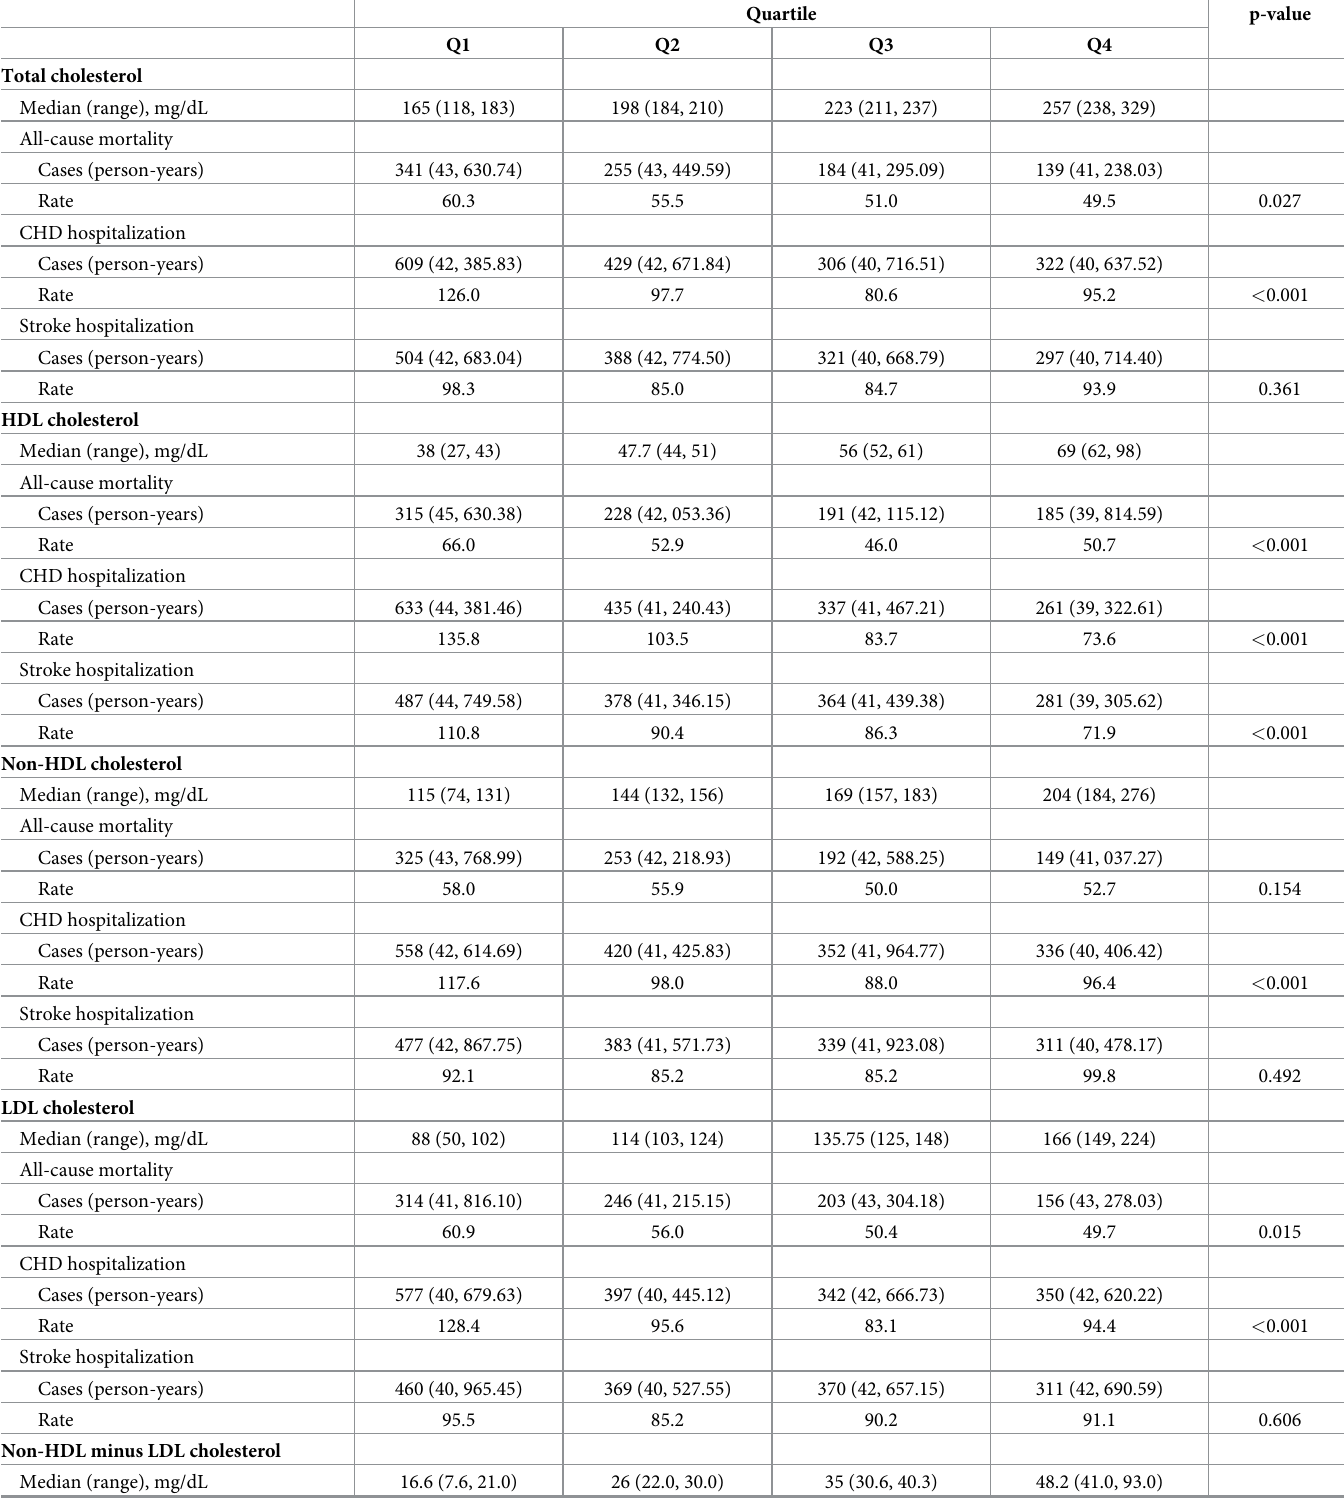
Table 2. Age and sex-adjusted rates of all-cause mortality and CVD hospitalization by quartile of serum lipids.